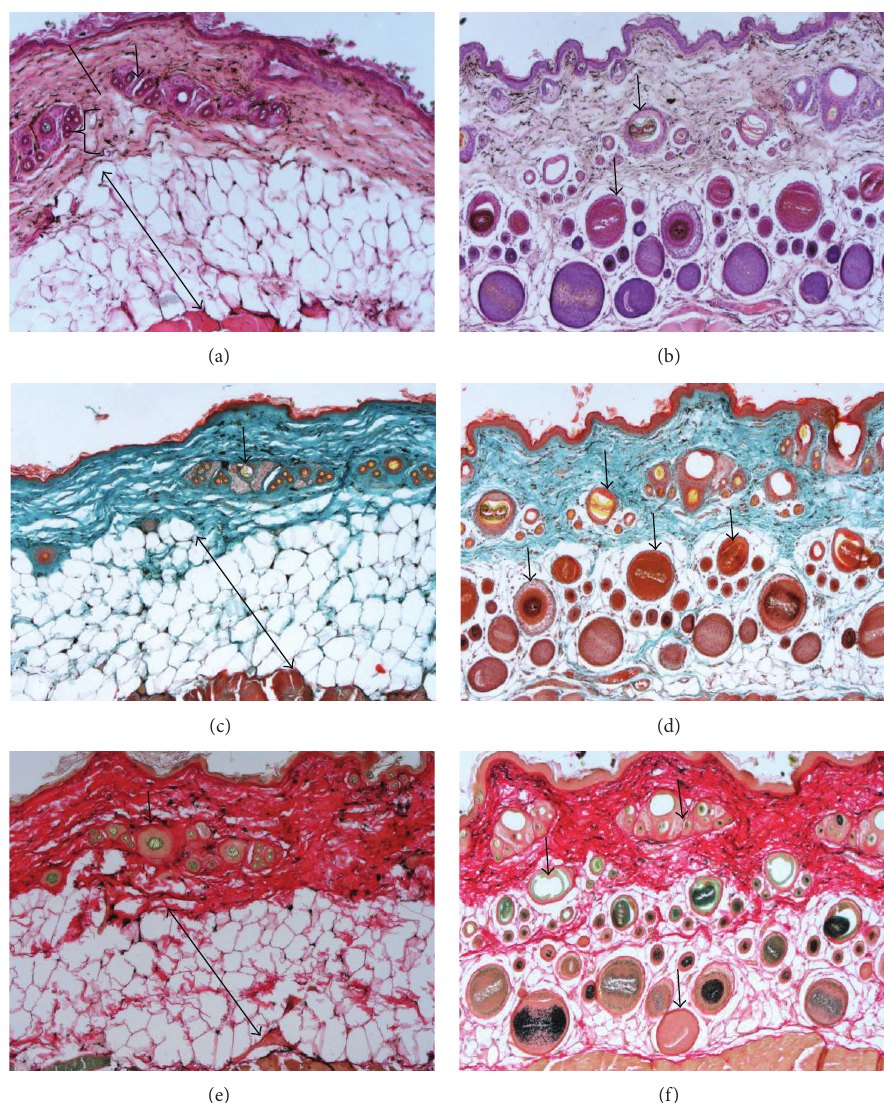
Figure1:Photomicrographsofstripeddorsalskinfromthefour-stripedmouse.(a),(c),and(e)areadultskinand(b),(d),and(f)juvenileskin. Hair follicles are present in the dermis of both the adult (left) and juvenile (right). However, a marked difference is visible in the hypodermis of the juvenile containing abundant hair follicles of varying sizes (right), whereas the adult has none (left). Note the epidermis (line), dermis (bracket), hypodermis (double arrow), and hair follicles (arrows). (a) and (b) Haematoxylin and Eosin staining. (c) and (d) Masson